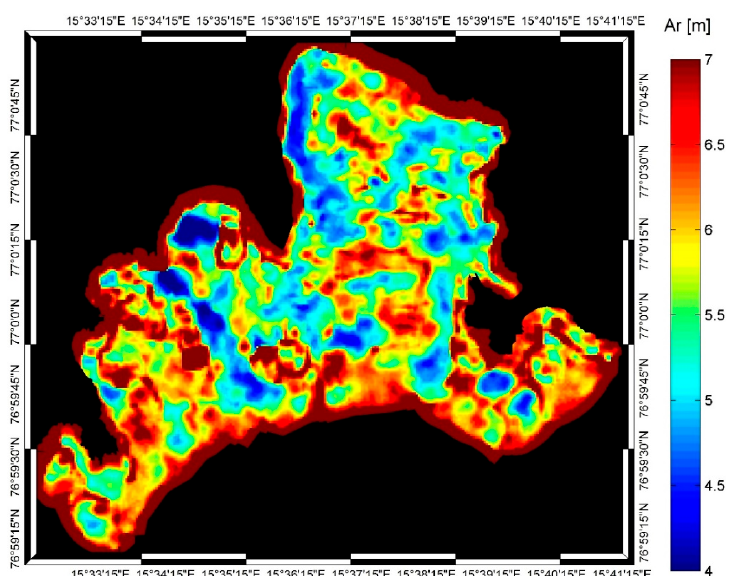
Figure 6. The autocorrelation length describing the terrain roughness with a spatial scale of 2 m–98 m, for DEM with a step of d = 1.0 m and the moving window with a side length of 140 m and 90% overlapping.